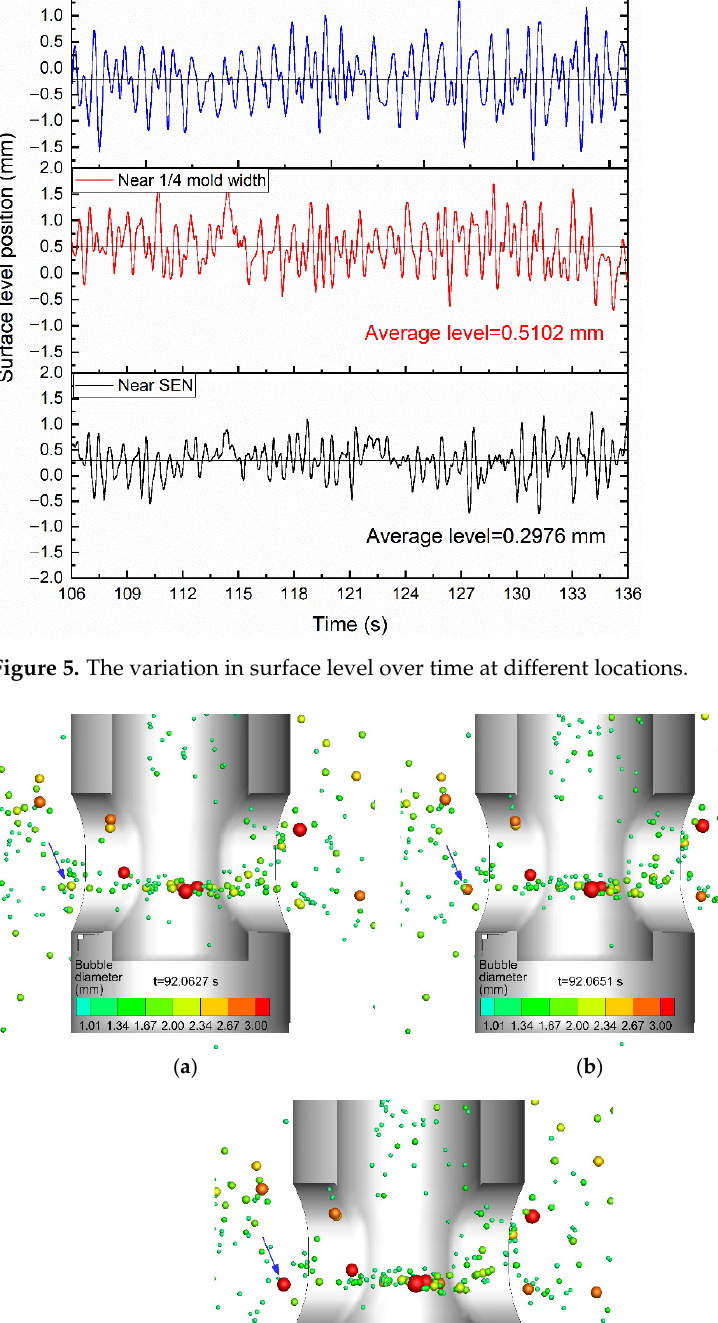
Figure 5. The variation in surface level over time at different locations.